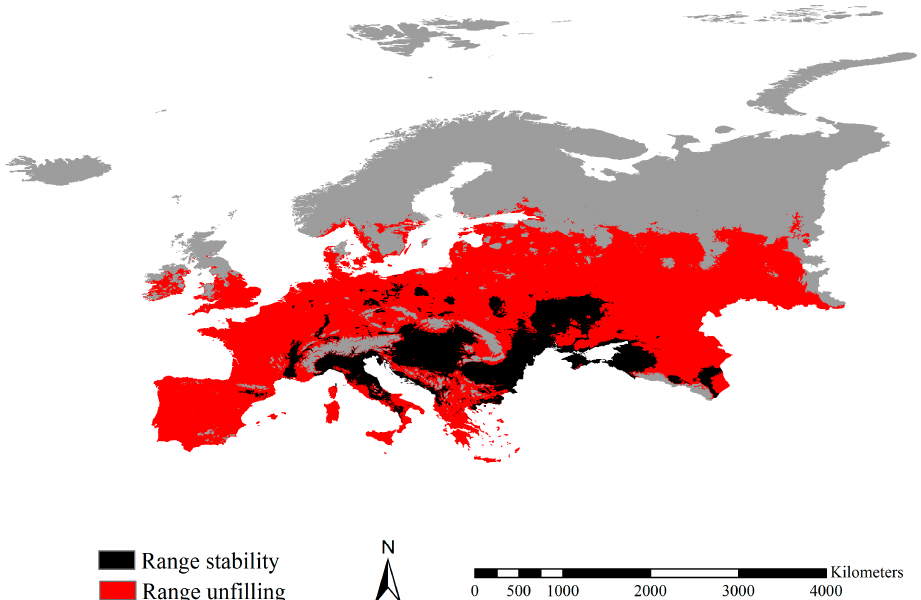
Figure 6. Range dynamics of the fall webworm in Europe and in North America. The red and black indicate unfilling and stabilized ranges, respectively. Range ratio and range similarity were ca. 5.50 and 0.31, respectively. The climatic potential ranges for the fall webworm in North America, but not the fall webworm in Europe, were mostly projected in vast regions of Europe, excluding Norway, Sweden, Finland, North Russia, Hungary, Croatia, Romania, and Ukraine. The climatic potential range for the fall webworm in both Europe and in North America was mostly identified in France, Austria, Hungary, Croatia, Romania, Bulgaria and Ukraine.